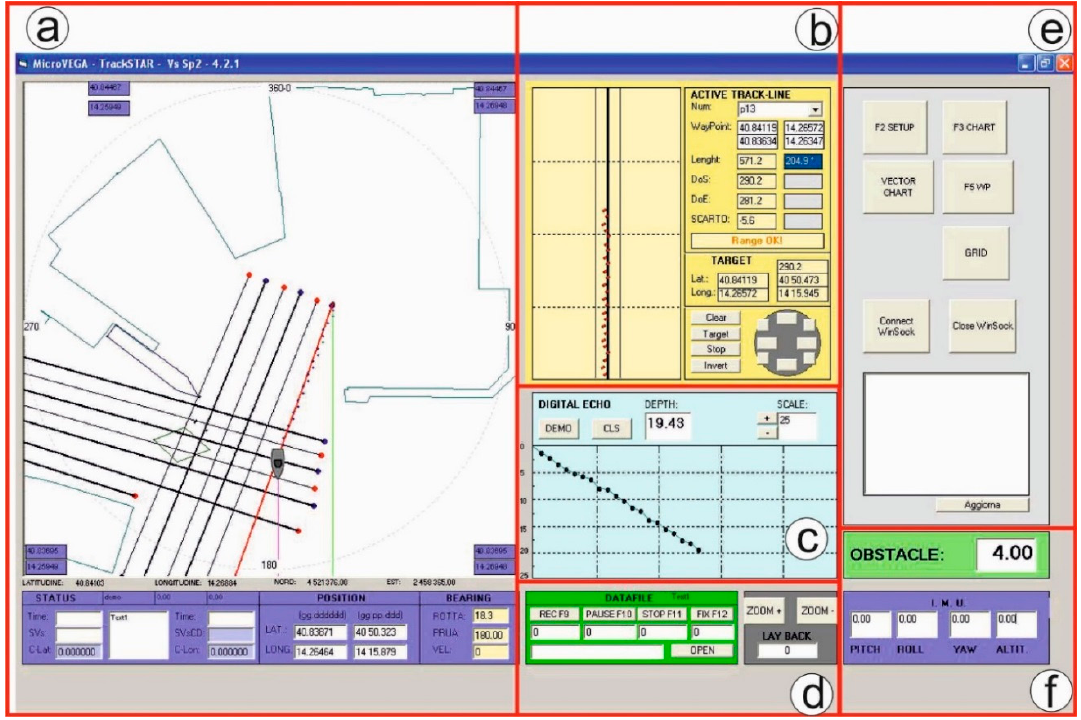
Figure 10. Trackstar desktop: ( a ) real time navigation; ( b ) deviation of the vessel from the planned line; ( c ) real time bathymetric profile; ( d ) real time data recording and datafile creation; ( e ) import of cartography and creation of navigation lines; ( f ) obstacle distance and attitude measurements.